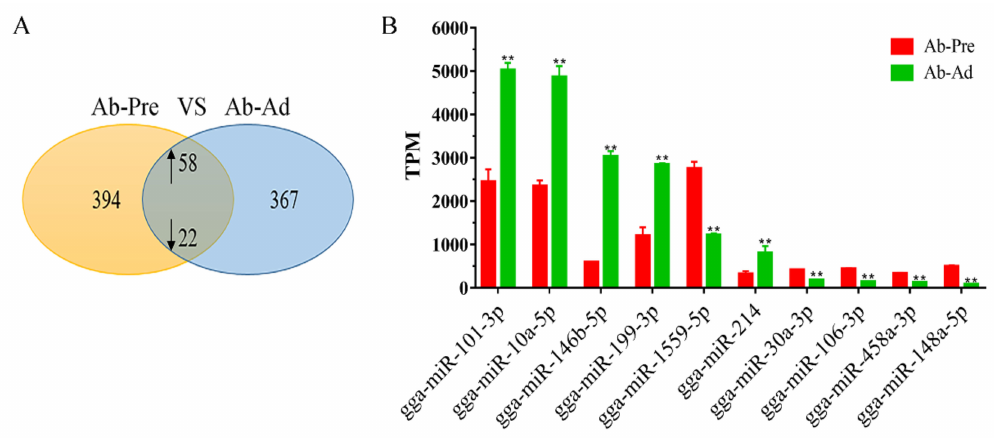
Figure 2. Analysis of di ff erentially expressed miRNAs. ( A ) The Venn diagrams of the di ff erentially expressed miRNAs (DEMs) between the preadipocytes (Ab-Pre) and di ff erentiated adipocytes (Ab-Ad) groups. ( B ) Top 10 most abundantly expressed miRNAs in the preadipocytes (Ab-Pre) and di ff erentiated adipocytes (Ab-Ad). The data are demonstrated as the means ± SEM; ** means p < 0.01.